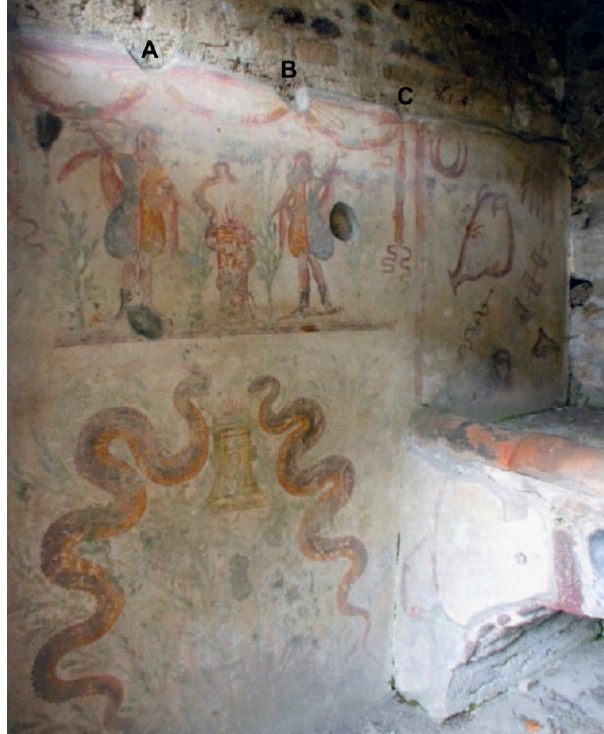
Figure 7. Casa del Maiale (9.9.b–c), Pompeii. Lararium located next to hearth of kitchen (k), with a scene of lares around an altar, above two circles approaching an altar. Pork products associated with a sacrifice to the lares on far right. Indications for hanging garlands shown by letters ( A – C ).